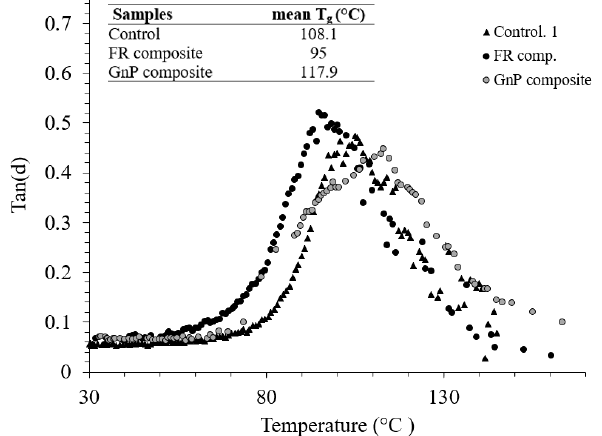
Figure 9. Loss factor (Tan δ ) vs. temperature from the dynamic mechanical analysis (DMA) tests.